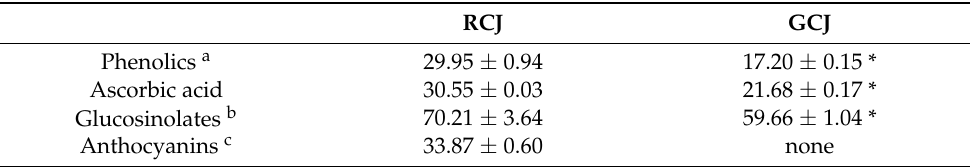
Table 1. Total phenolics, ascorbic acid, glucosinolates, and anthocyanins content in red cabbage juice (RCJ) and green cabbage juice (GCJ) (mg/100 mL of juice).